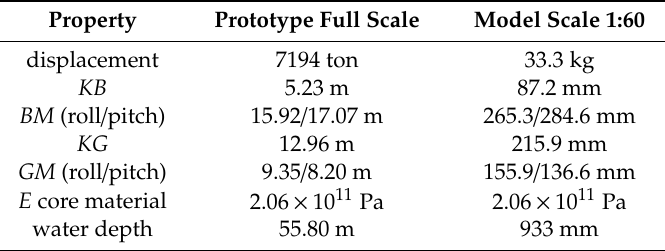
Table 3. Main properties of the floater.